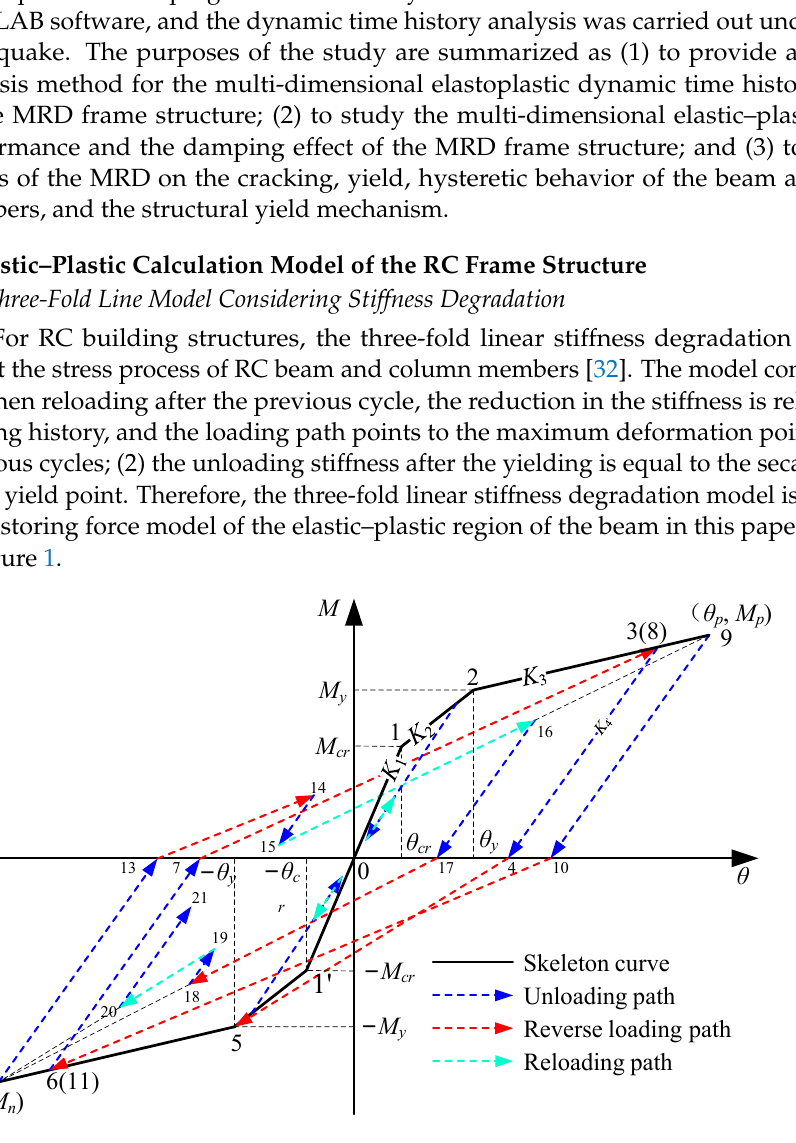
Figure 1. Three-fold linear stiffness retrograde model of RC beam–column element.